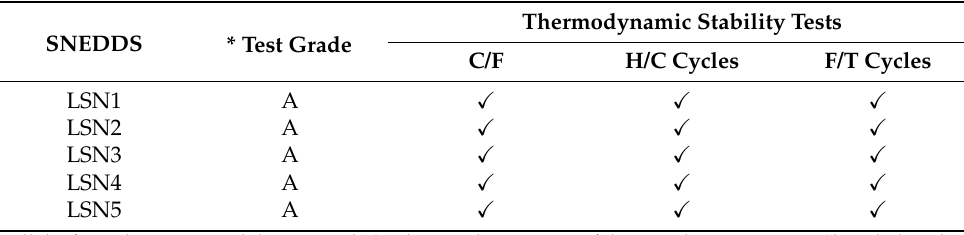
Table 3. Qualitative results of thermodynamic stability and self-nanoemulsification efficiency of LUT-SNEDDS in the presence of different